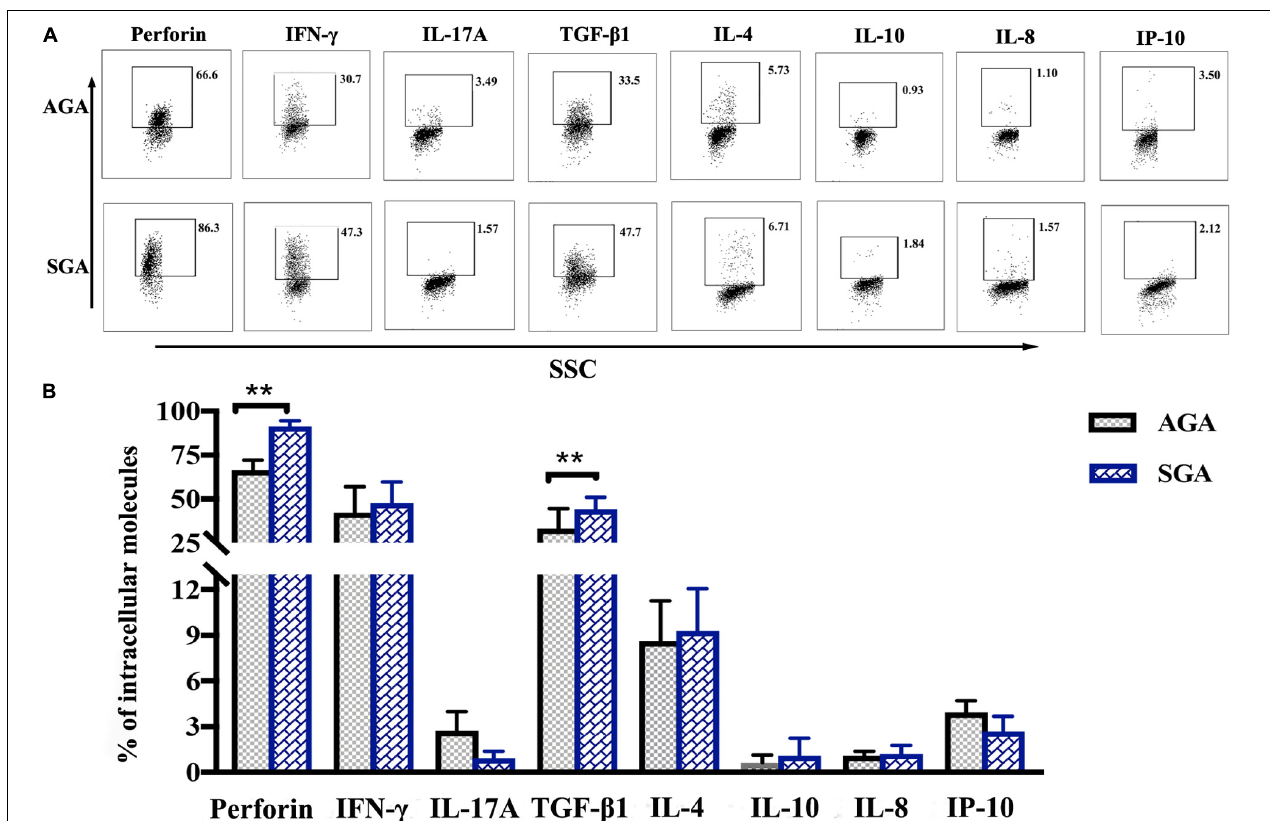
FIGURE 4 | The profile of intracellular expression of dNK cells. Cells were treated with PMA, ionomycin, and brefeldin for 4 h and were then fixed and permeabilized after the surface staining of CD3 and CD56. Cells were then stained for perforin, IFN- γ , IL-17A, TGF- β 1, IL-4, IL-10, IL-8, and IP-10. (A) Representative flow cytometry analysis of the expression of perforin, IFN- γ , IL-17A, TGF- β 1, IL-4, IL-10, IL-8, and IP-10. (B) Statistical analysis of intracellular molecules expressed by dNK cells from SGA ( n = 10) and AGA ( n = 13). ** p < 0.005.